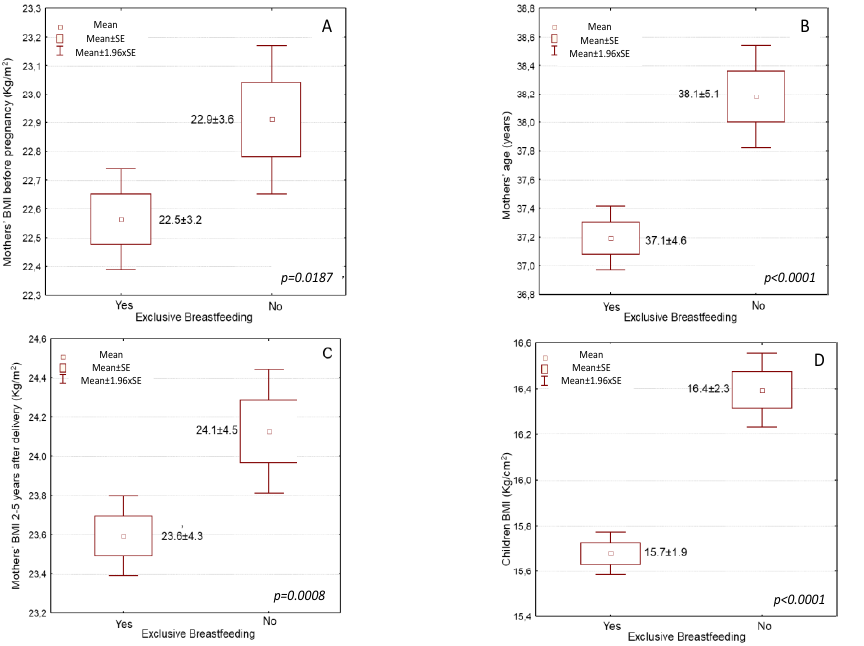
Figure 1. Associations of exclusive breastfeeding for at least four months with ( A ) mothers’ BMI before pregnancy, ( B ) mothers’ age at the time of study, ( C ) mothers’ BMI after 2–5 years from delivery, and ( D ) children’s BMI at the time of study.